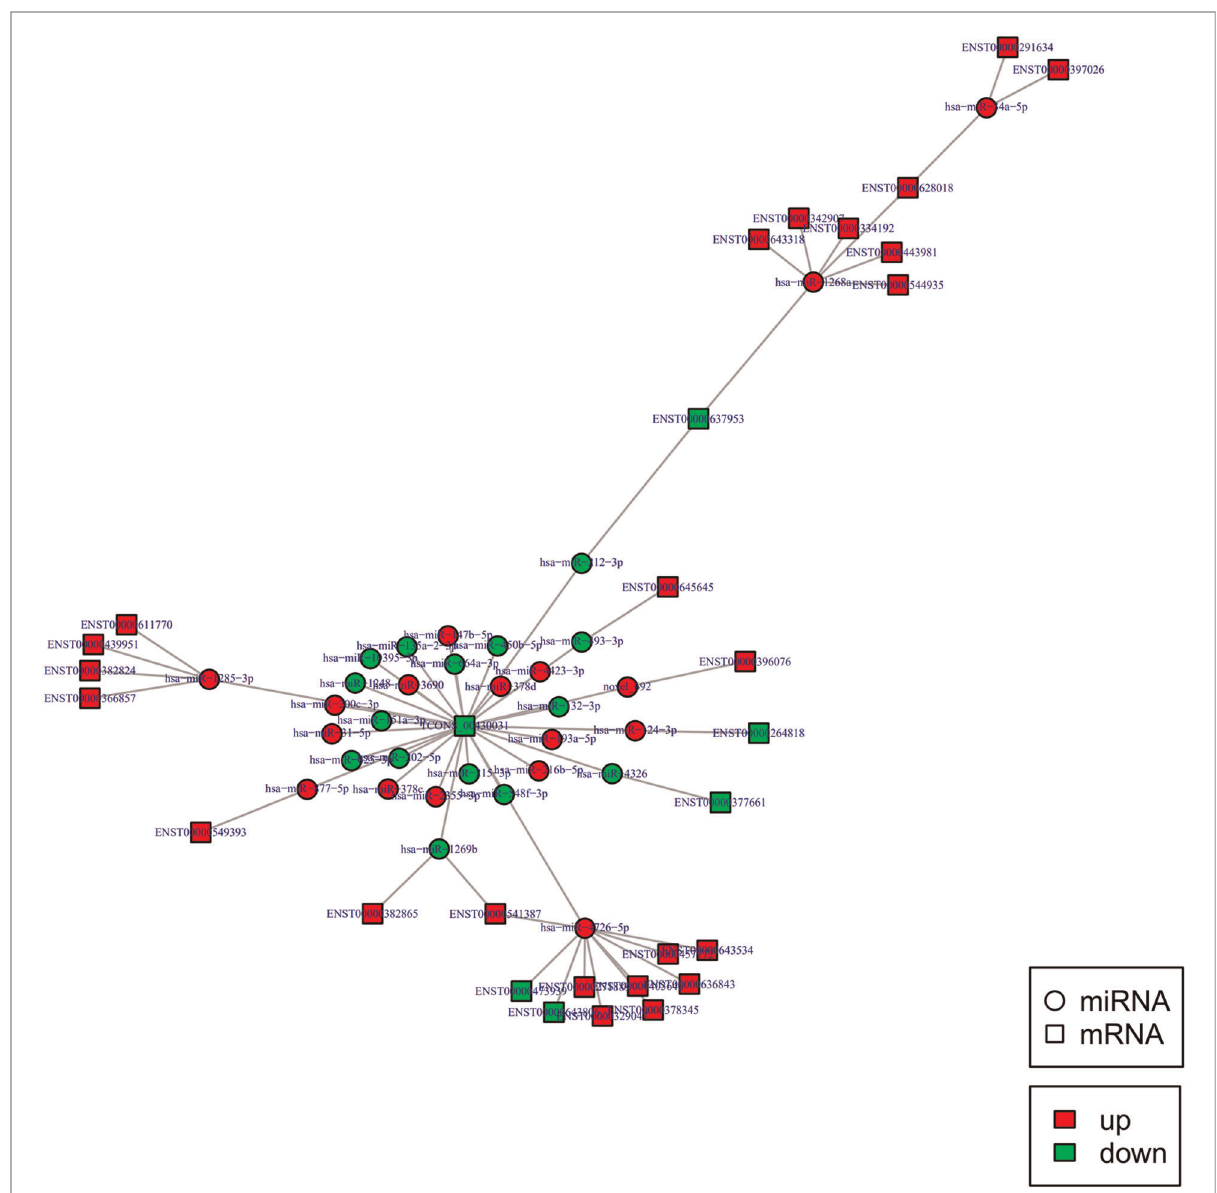
FIGURE 5 DEmiRNA and targeted DEmRNA regulatory network. Circle: miRNA, square: lncRNA. Red: up-regulation, green: